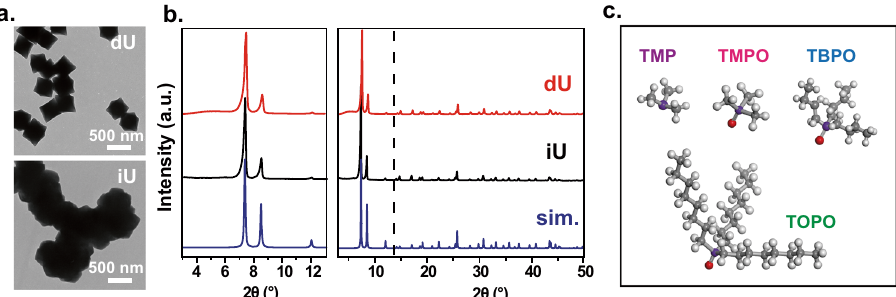
Fig.1|Standardcharacterizations.a TEMimagesofUiO-66particles. b ThePXRD patterns of ideal and defective UiO-66. c The chemical structures of 31 P probe moleculesusedinthiswork. “ dU ” representsdefectiveUiO-66, “ iU ” representsideal UiO-66, and “ sim. ” corresponds to the PXRD simulation result. TMP: